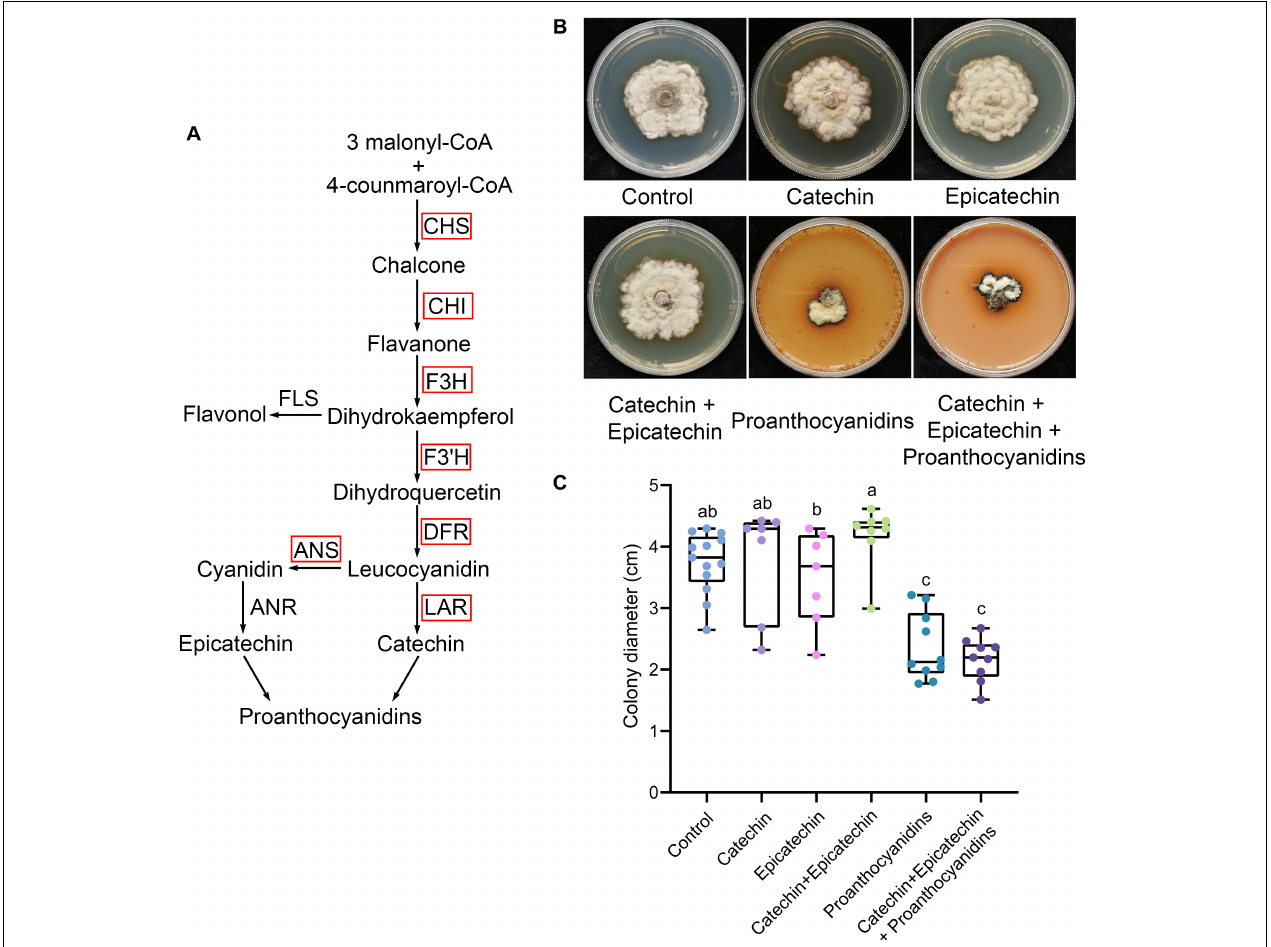
FIGURE 2 | Proanthocyanidins inhibit the vegetative growth of Scleromitrula shiraiana . (A) Most of the key genes in the biosynthetic pathway of proanthocyanidins in infected mulberries were up-regulated. CHS, chalcone synthase; CHI, chalcone isomerase; F3H, flavanone 3–hydroxylase; F3 (cid:48) H, flavonoid 3 (cid:48) –hydroxylase; DFR, dihydroflavonol 4-reductase; LAR, leucoanthocyanidin reductase; ANS, anthocyanin synthase. (B–C) The effects of proanthocyanidins, catechin and epicatechin on the vegetative growth of S. shiraiana . S. shiraiana is another pathogen of mulberry sclerotial disease. Colony photographs and colony diameter measurements were taken on PDA medium at 25 ◦ C after 13 days. Control indicates growth without any treatment. Different letters (a, b) indicate statistical differences ( P < 0.05) ( n > 7, one-way ANOVA with post hoc Duncan’s test). The experiments were repeated at least three